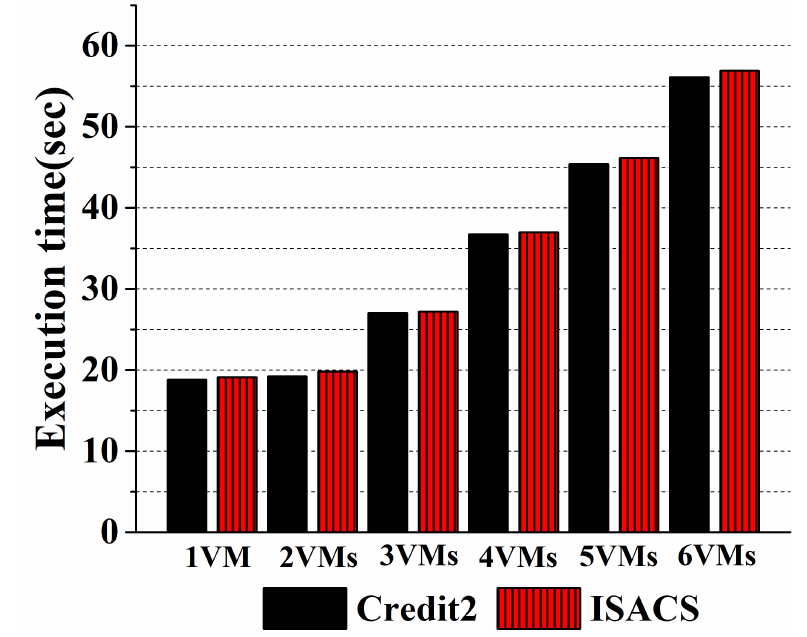
Figure 13. Average execution times for 15 experiments according to the VM configurations in the mixed